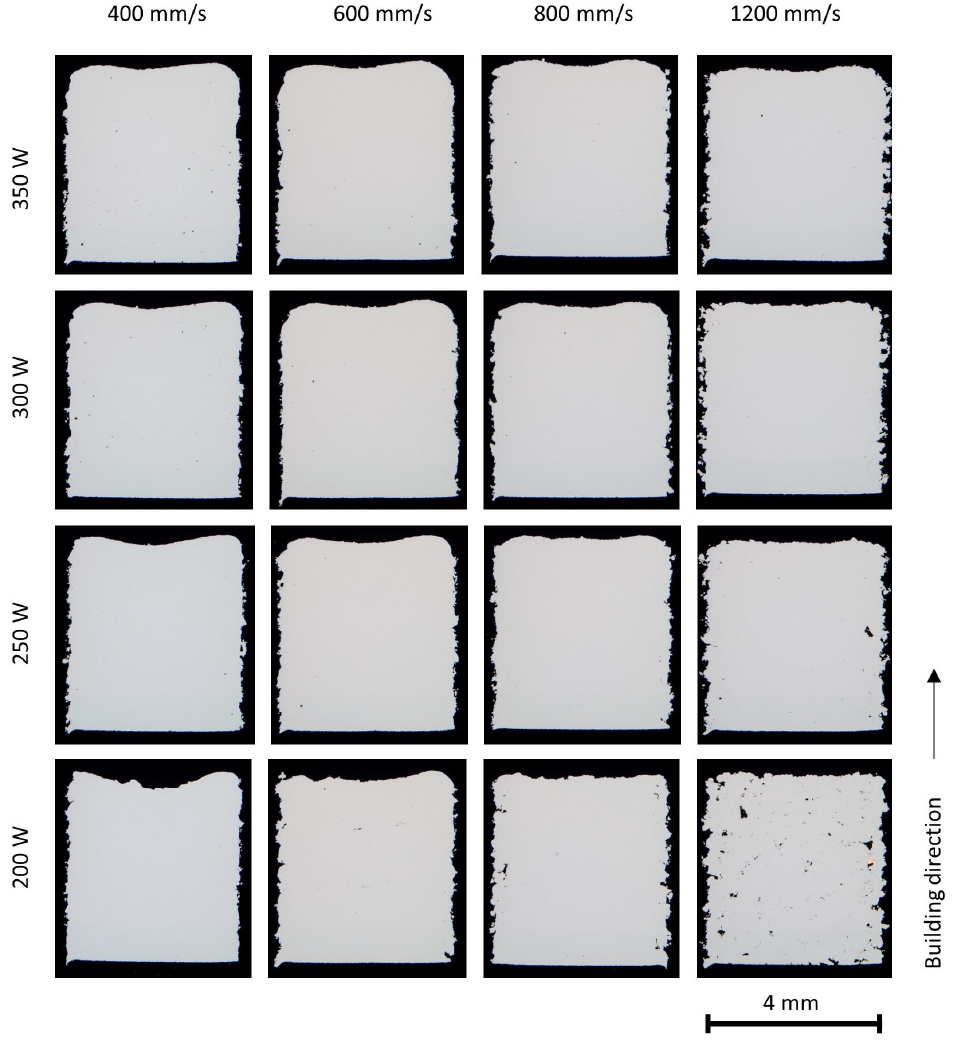
Figure 6. Stereo microscopy of the X2CrNiMo17-12-2 parts (4 × 4 × 5 mm 3 ) built with various process parameters.